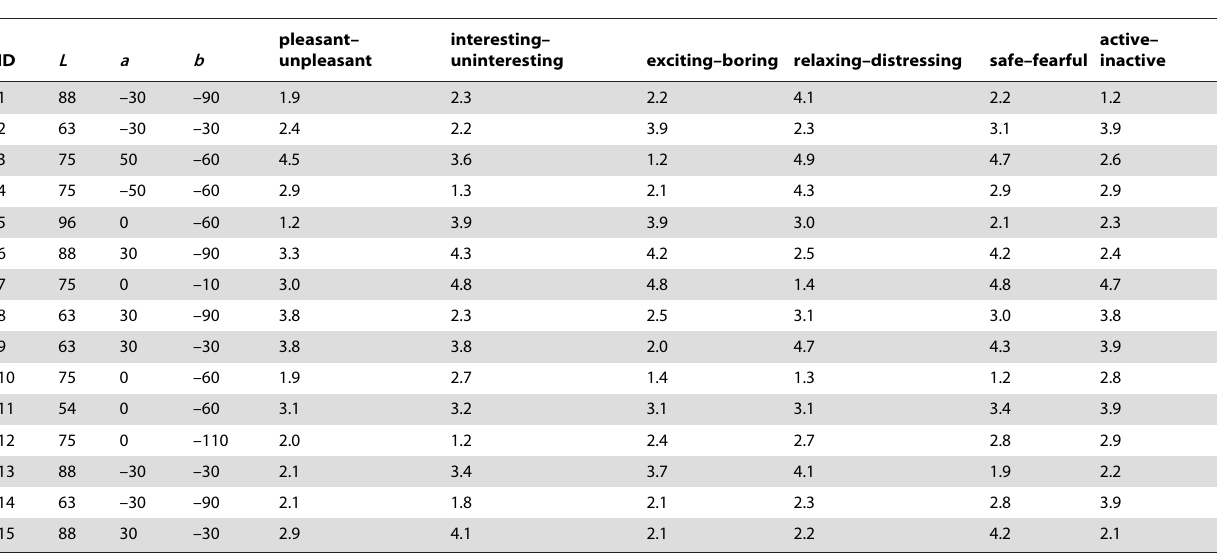
Table 2. Experiment 2: Matrix for the CCD and